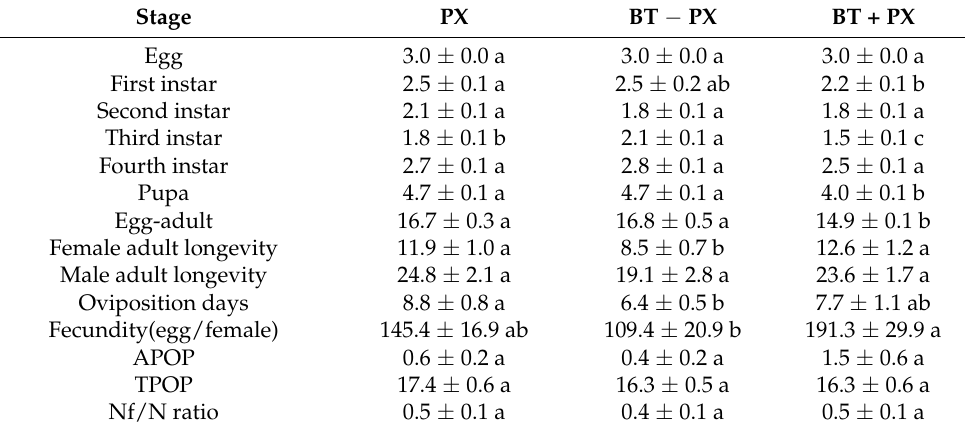
Table 3. Developmental durations and reproduction (M ± SE) of Plutella xylostella when feeding on Chinese kale alone (PX), with prior whitefly damage (BT − PX) or with simultaneous whitefly damage (BT + PX).